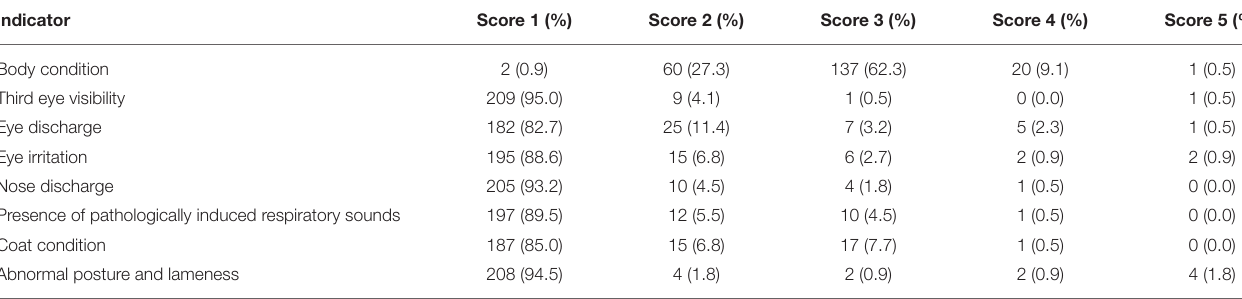
TABLE 4 | Number of cats that were rated specific scores in individual indicators upon admission to the shelter.